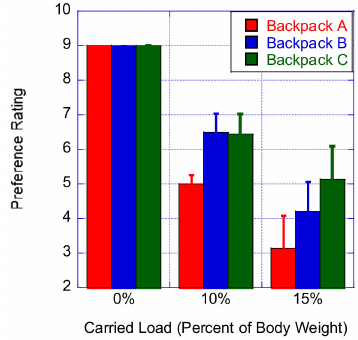
Figure 5. E ff ect of the percent of carried load on the backpack preference